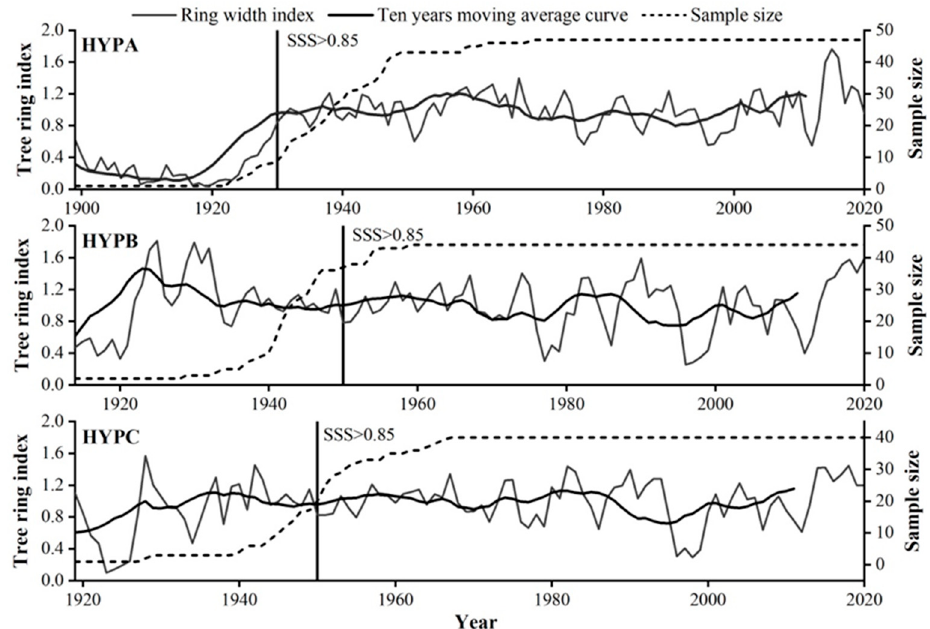
Figure 3. Standard chronologies and sample sizes of the annual ring widths of L. principis-rupprechtii trees growing at different elevations on Guancen Mountain.